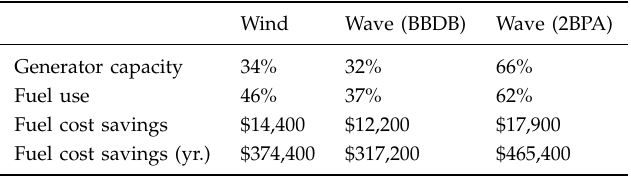
TABLE IV P ERCENT REDUCTION IN REQUIRED GENERATOR CAPACITY ,